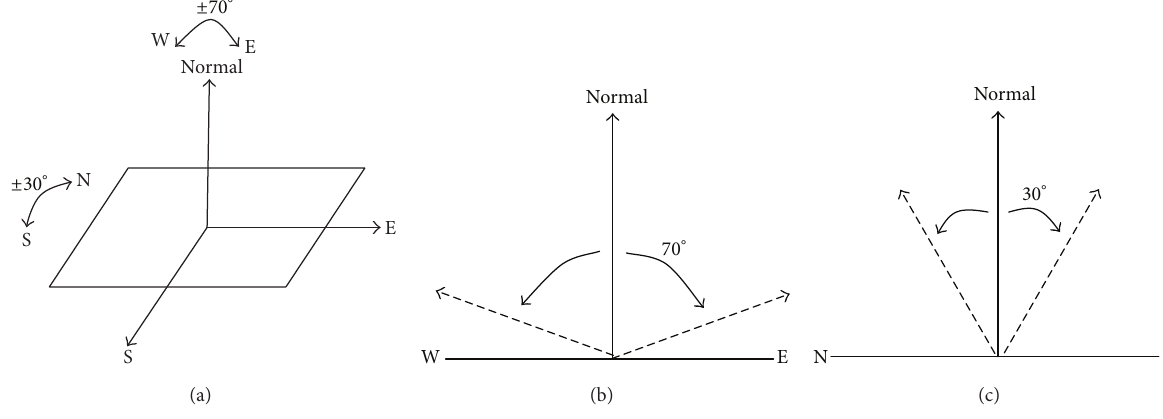
Figure 5: The reference (“zero”) positions for the angular fields of the two rotational axes.